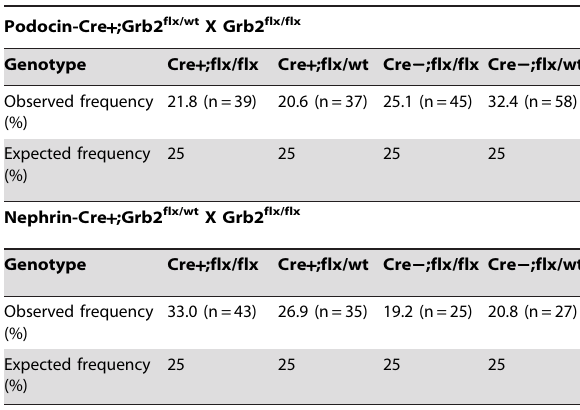
Table 1. Genotype analysis of the progeny born from Podocin / Nephrin -Cre; Grb2 flx crosses.